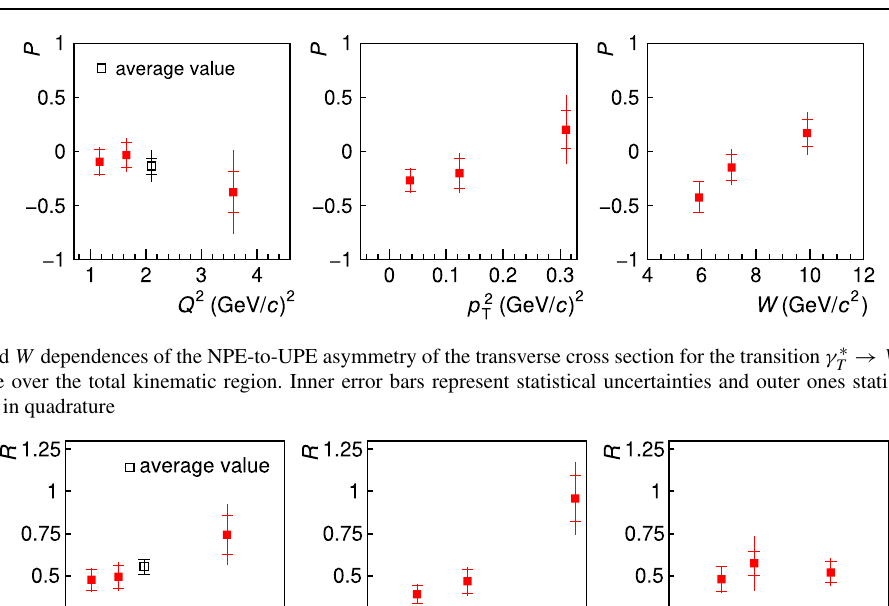
Fig. 11 Q 2 , p 2 and W dependences of the longitudinal-to-transverse cross-section ratio R . The open symbol represents the value obtained for the T total kinematic region. Inner error bars represent statistical uncertainties and outer ones statistical and systematic uncertainties added in quadrature. Note that the additional positive uni-directional systematic uncertainty due to the approximation R ≈ R (cid:6) is not shown here, see text for